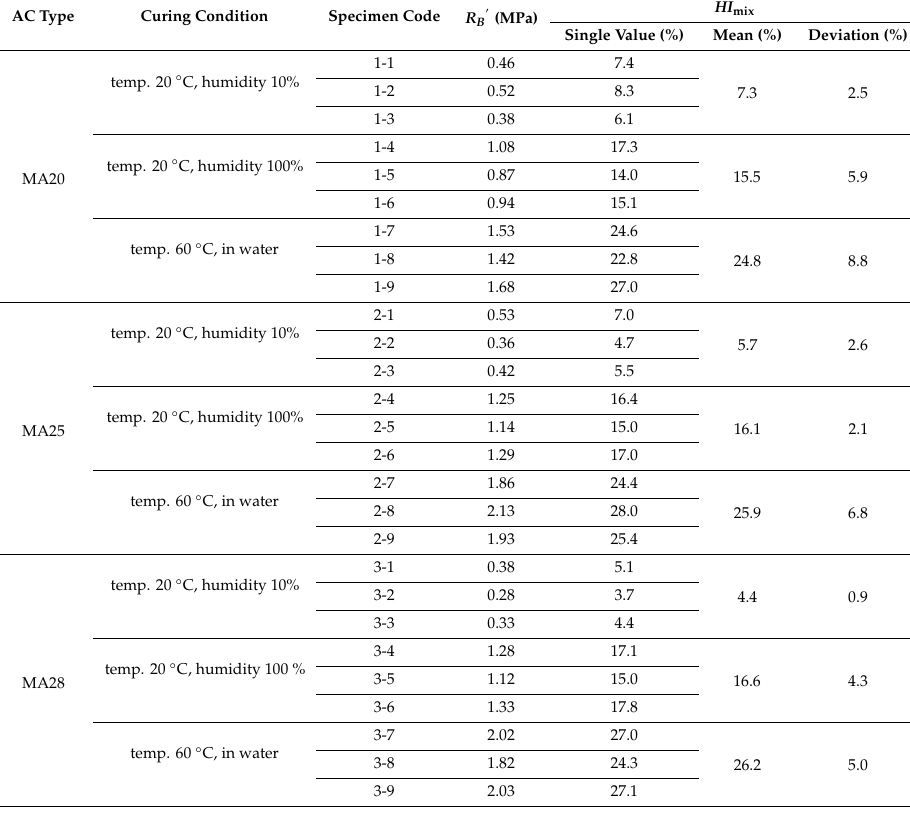
Table 9. Self-healing test results of the ECC-SFP